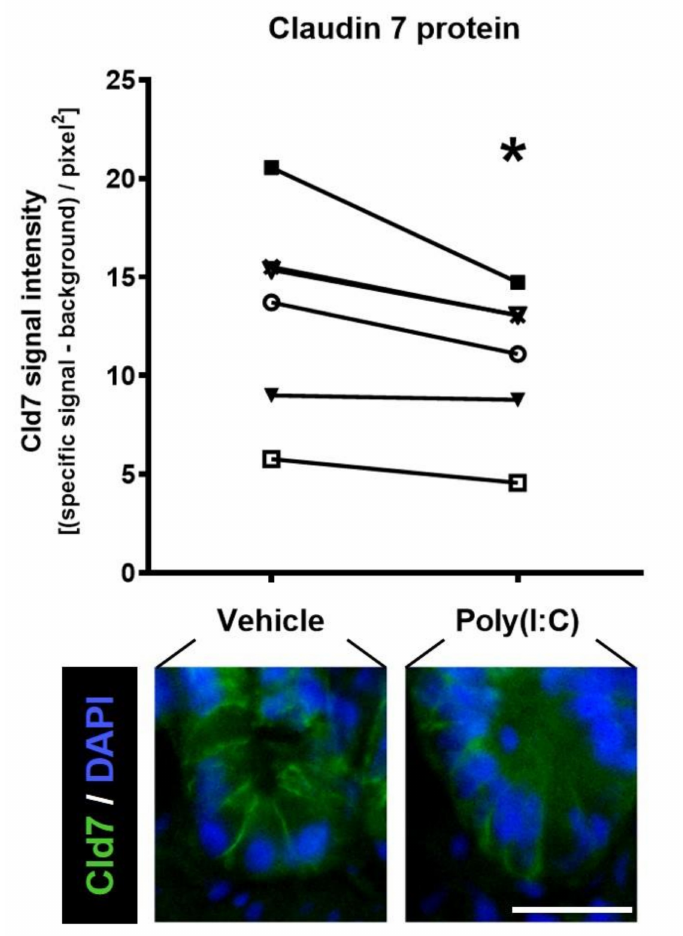
Figure 2. Claudin 7 protein in the ileal mucosa upon treatment with a TLR3 agonist. Rat ilea were treated ex vivo for 2 h with either vehicle (saline) or the TLR3 agonist, Poly(I:C) (200 µ g/mL). Claudin 7 (Cld7), a component of tight junctions but also relevant for cell adhesion, was analyzed by immunofluorescence. In the graph, each line represents one rat (total n = 6) and connects the value obtained in the vehicle-treated portion of ileum with the value obtained in the corresponding Poly(I:C)-treated tissue. There was a loss of specific (lateral) signal in every case. Bar = 25 µ m, * p < 0.05 by paired t test. Original data from Loreto Olavarr í a-Ram í